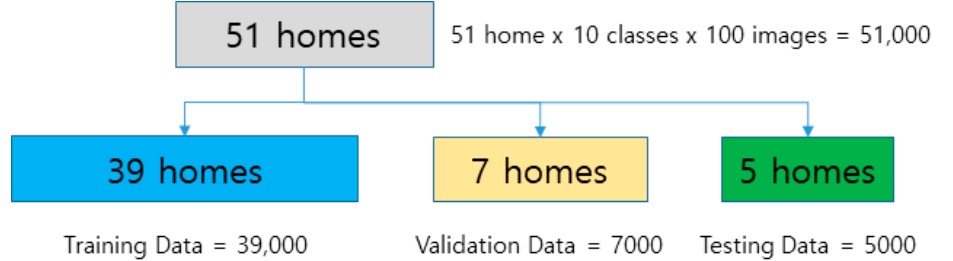
Figure 15. Data configuration for training, validation, and testing data set.